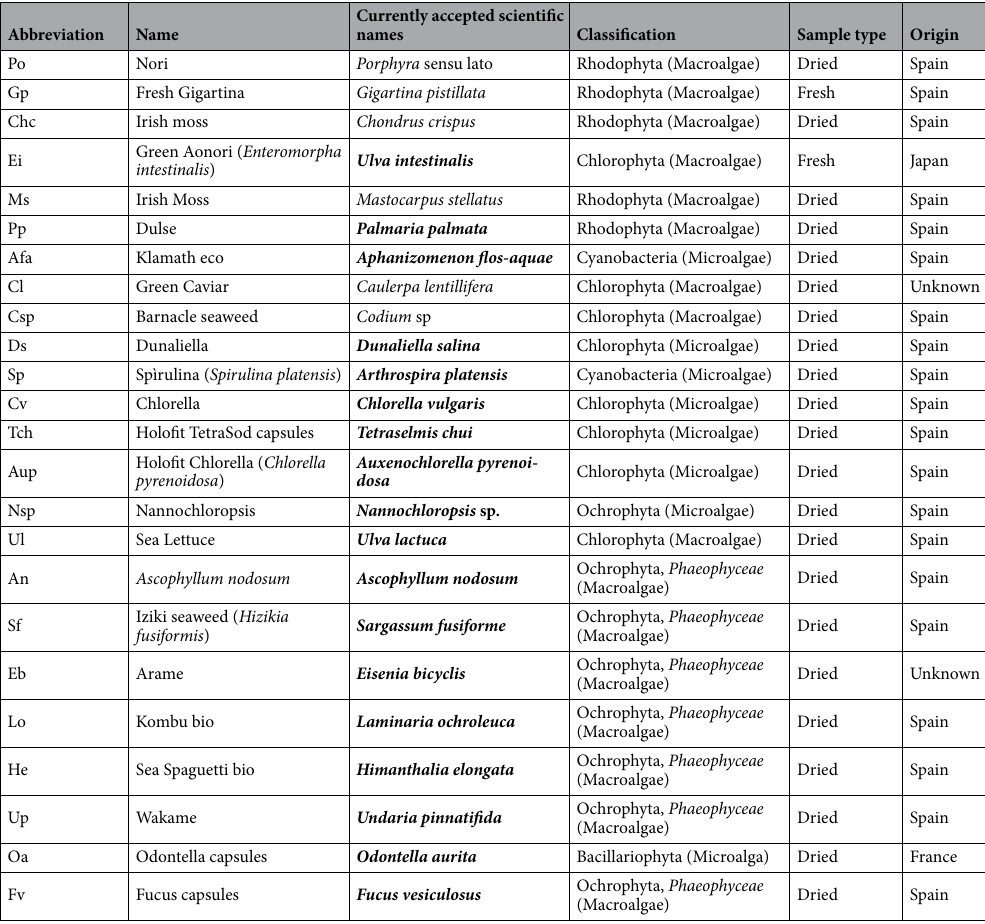
Table 4. Product information retrieved from the label in commercial microalgae and macroalgae (or seaweeds). The algae species included in the novel food catalogue, the union list of authorized novel foods, and official member states’ lists of food and food supplements in Europe are highlighted in bold.